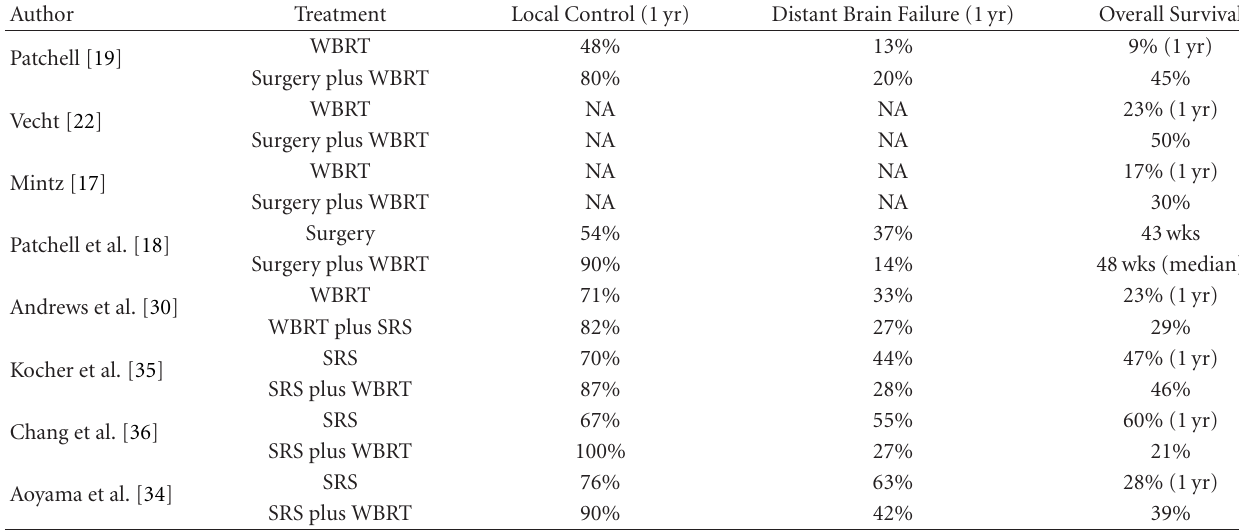
Table 1: Randomized Trials for Treatment of Brain